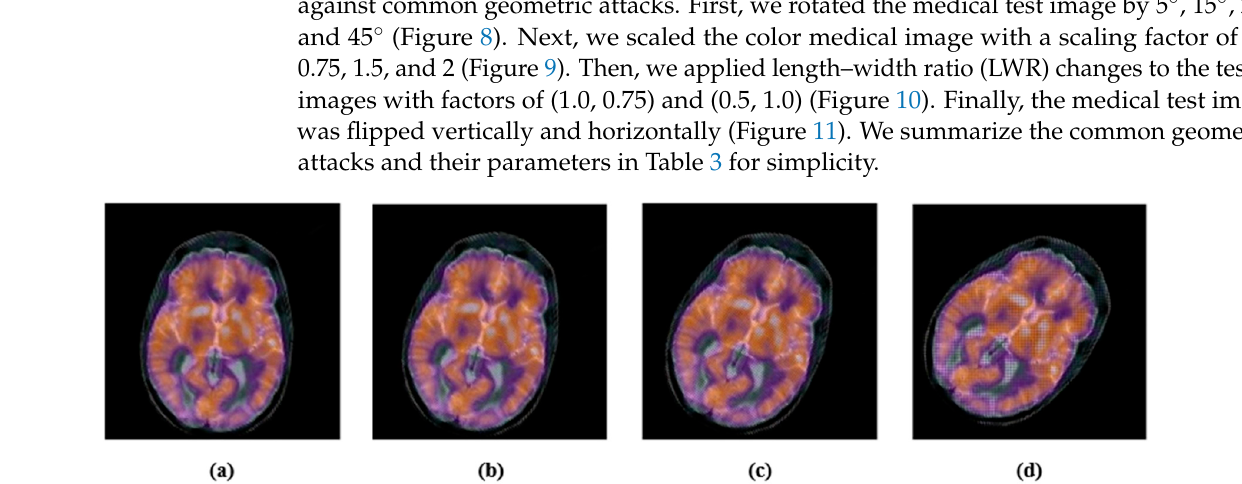
Figure 8. Rotated Images: ( a ) 5 ◦ ; PSNR = 16.5233; ( b ) 15 ◦ ; PSNR = 15.1828; ( c ) 25 ◦ ; PSNR = 14.3906; ( d ) 45 ◦ ; PSNR =